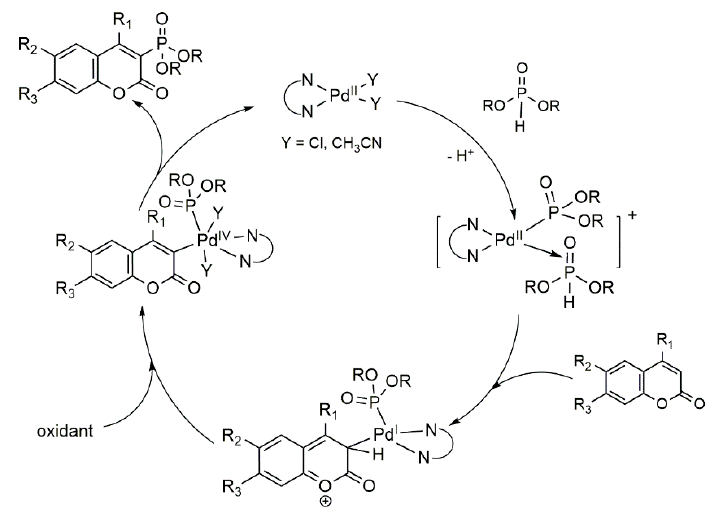
Scheme 11. Proposed mechanism for the synthesis of substituted dialkyl 2-oxo-2 H -1-benzopyran-